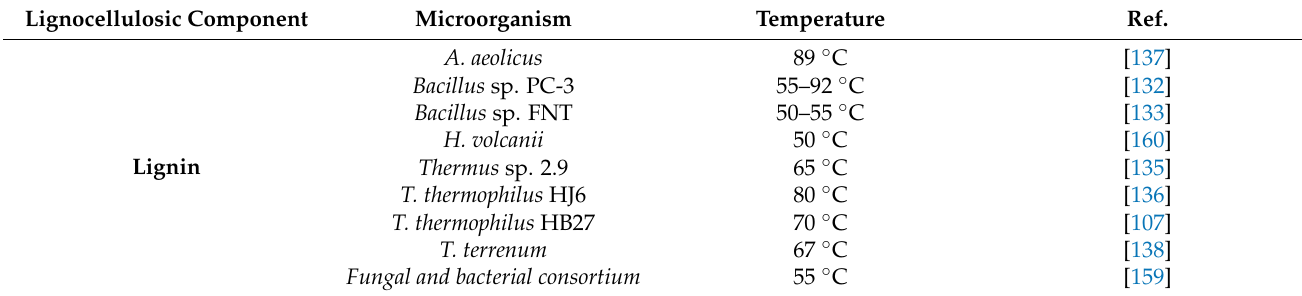
Table 5. Examples of thermophilic bacteria and archaea able to hydrolyze the lignocellulose. Lignocellulosic Component Microorganism Temperature Ref. A.